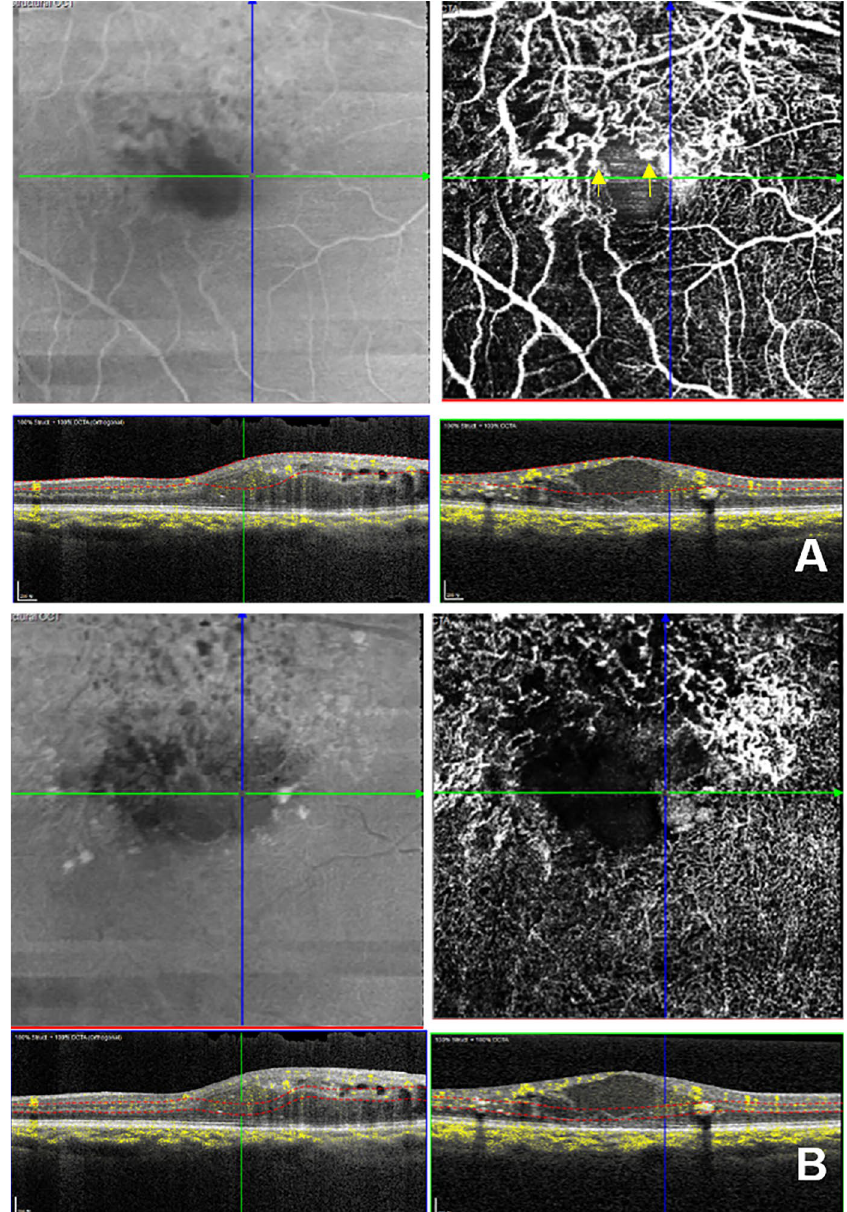
Figure 3. OCT and OCTA images of a case with five previous injections and 38-month disease duration. This case shows a grade 2 nonperfusion area (axis is about 150 to 160 degrees). ( A , B ) Top left is the en face OCT image. Top right is the en face OCTA image. The bottom left is the vertical B-scan with flow signal. The bottom right is the horizontal B-scan with flow signal. A . SSPiM with flow signal was observed at the vascular– nonvascular junction (junction between the perfused retina and the nonperfused retina) in the SVC (top right). Microaneurysms were observed near the SSPiM (yellow arrow, top right). ( B ) SSPiM with flow signal was observed at the vascular–nonvascular junction in the DVC (top right). Photoshop CC 2017 (Adobe Systems Co, San Jose, CA) was used to create this